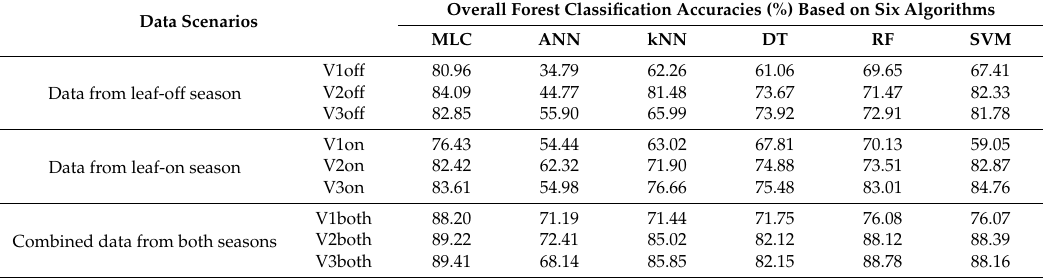
Table 8. The summary of overall average accuracies of all forest types among six classification algorithms based on different data